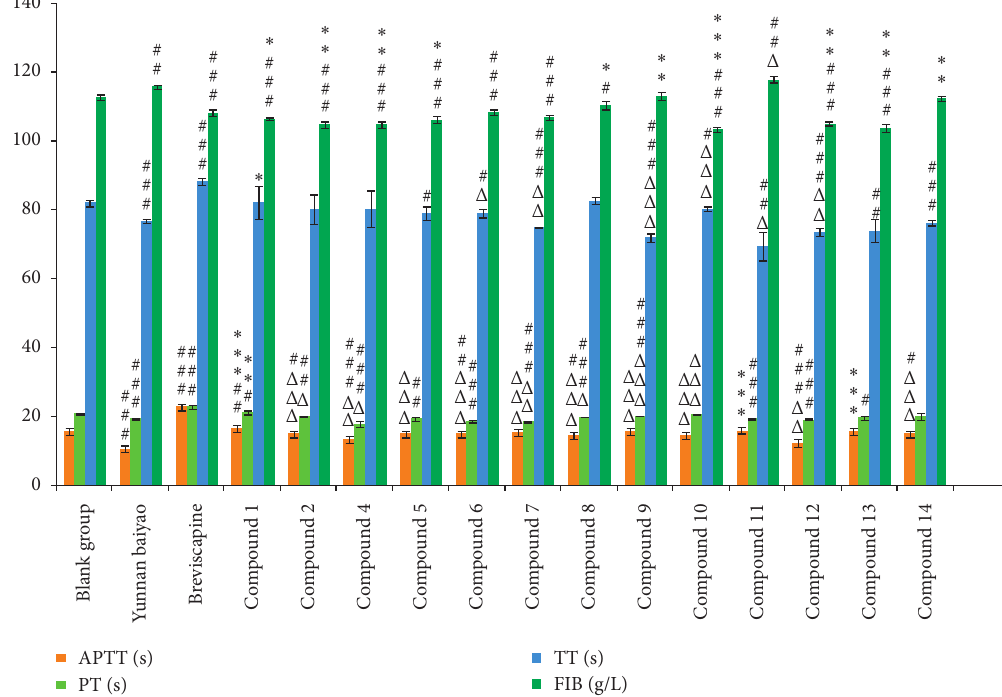
Figure 2: Effects of compounds from A. persica flowers on plasma coagulation parameters in vitro ( X ± SD, ( n � 4). Compared with blank group, # P < 0 . 05, ## P < 0 . 01, and ### P < 0 . 001. Compared with Yunnan Baiyao, Δ P < 0 . 05, ΔΔ P < 0 . 01, and ΔΔΔ P < 0 . 001. Compared with breviscapine, ∗ P < 0 . 05, ∗∗ P < 0 . 01, and ∗∗∗ P < 0 .